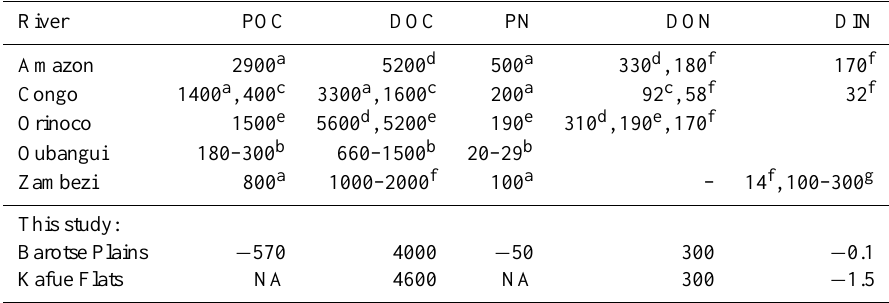
Table 2. Yields of carbon, nitrogen, and phosphorus in kilograms (C or N) per square kilometer per year from large river basins and floodplain yields from the Barotse Plains and Kafue Flats. Yields for this study are calculated from the maximum inundated areas mentioned in the “Study Sites” section, assuming 6 months of dry-season export and 6 months of wet-season export. POC and PN yields from the Kafue Flats during the dry season could not be estimated due to a lack of measurements at downstream locations, so no yearly yields were calculated. River